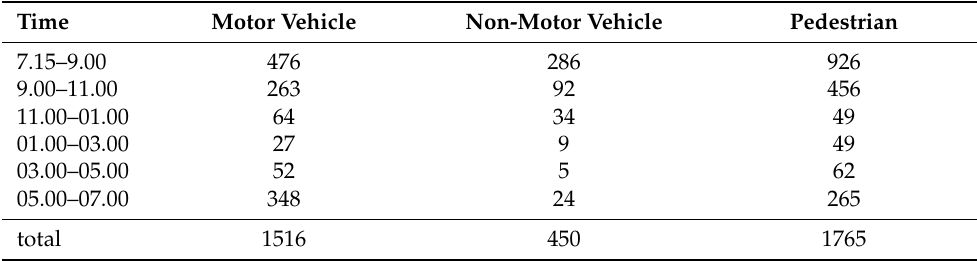
Table 3. Traffic flow